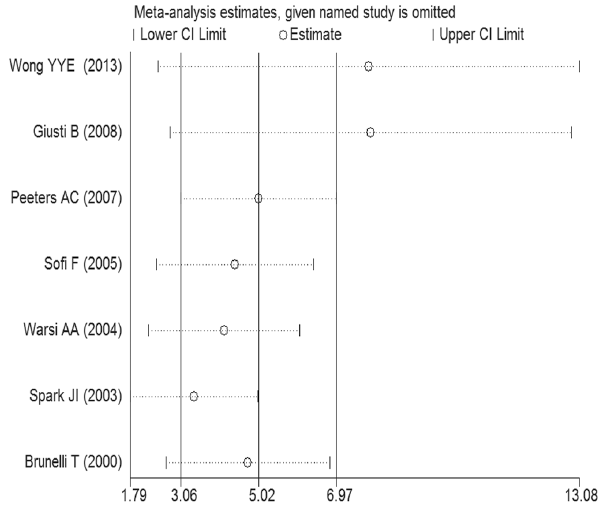
Figure 6. OR and 95% CI by omitting each study from the included studies of plasma Hcy and